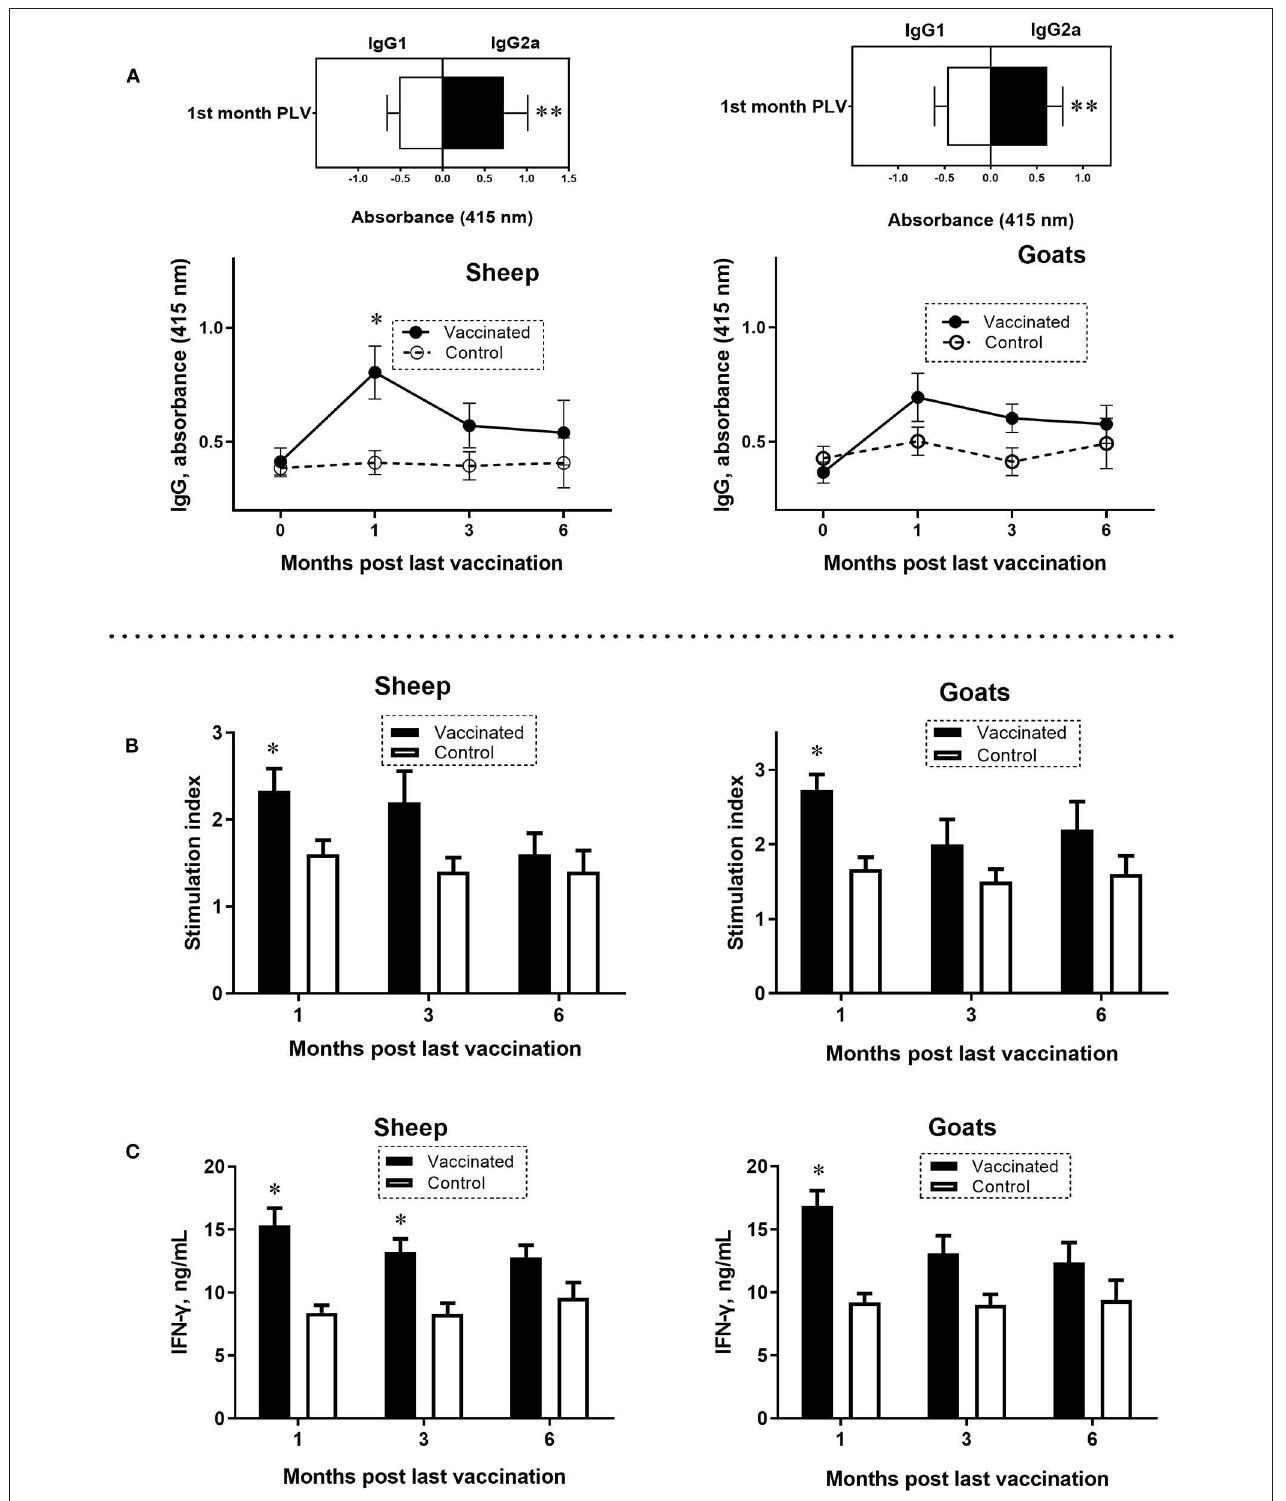
FIGURE 2 | Antigen-specific enzyme-linked immunosorbent assay (ELISA) IgG, IgG1, and IgG2a antibody responses (A) and lymphocyte stimulation index (B) and interferon γ (IFN- γ ) production (C) in peripheral blood mononuclear cells (PBMCs) of sheep and goats at 0 or first, third, and sixth month PLV. A mixture of Brucella L7/L12, Omp16, Omp19, and superoxide dismutase proteins was used to simulate PBMCs and in ELISA. Sheep and goats were vaccinated thrice concurrently via